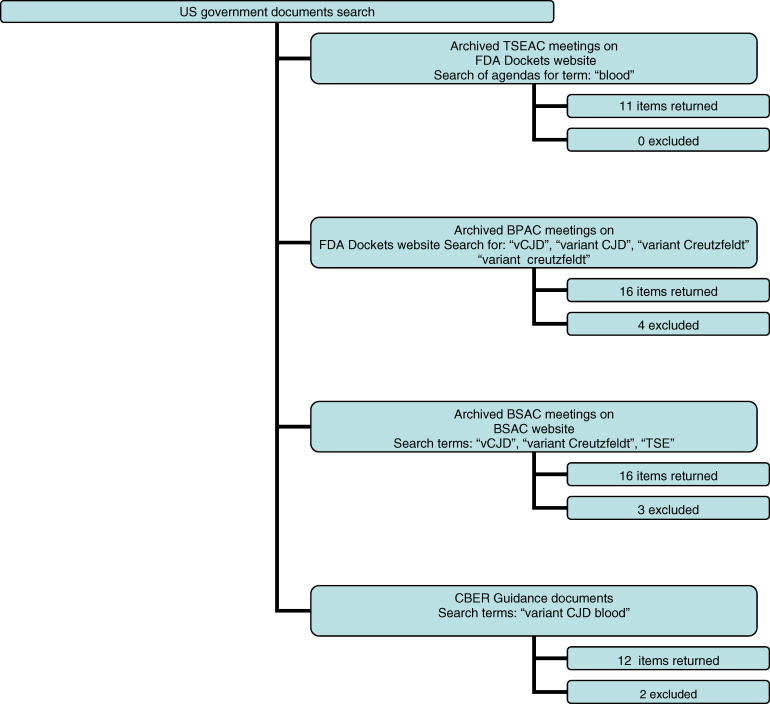
US Government DocumentsSearches conducted with results returned and excluded at each step.